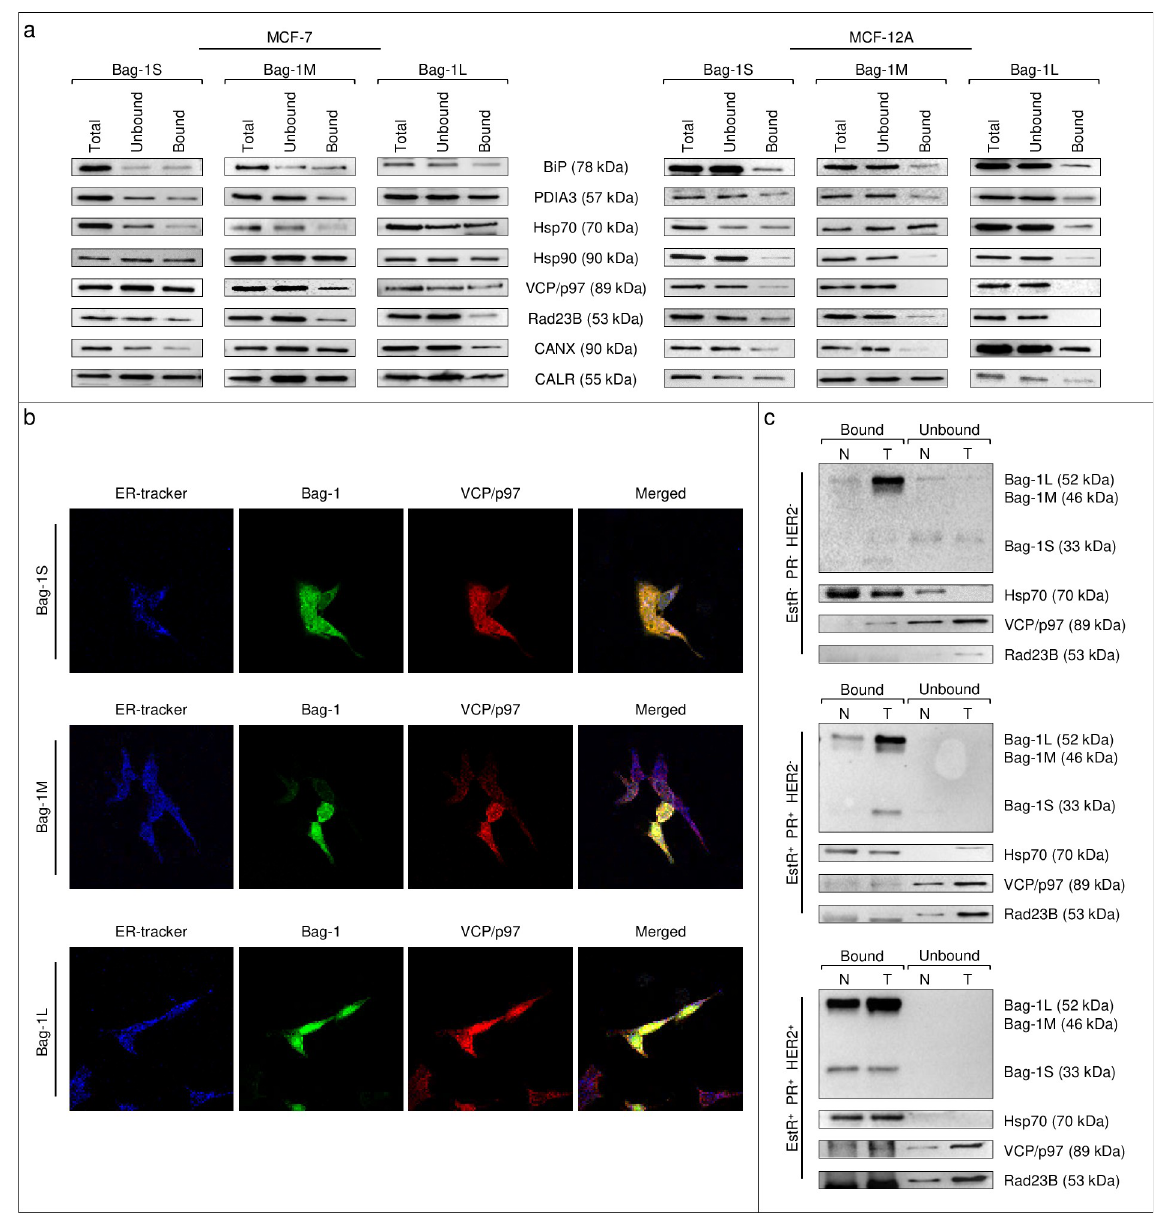
Fig 3. Bag-1 isoforms interact with protein quality control elements in breast cell lines and tissues. a . Immunoblotting assays for interaction partners of purified Bag-1S, M and L proteins extracted from MCF-7 and MCF-12A. Total, unbound, and Bag-1-bound protein extracts were blotted for BiP, PDIA3, Hsp70, Hsp90, VCP/p97, Rad23B, Calnexin and Calreticulin. b . Immunocytochemistry for assessment of Bag-1’s co-localization with interaction partners. MCF-7 cells transfected with Bag-1 isoforms were stained with Bag-1 antibody and VCP/p97. c . Co-immunoprecipitation assay in tissues from breast cancer patients. Interaction of Bag-1 with VCP/p97, Rad23B, and Hsp70 was increased in tumor tissues compared to normal. n = 4 for each molecular subtype of breast cancer. T: Tumor tissue, N: Neighboring normal tissue.